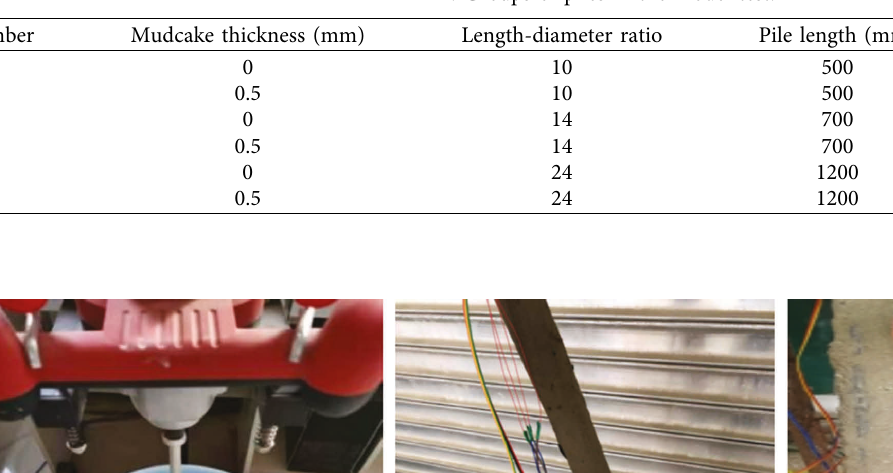
Table 1: Groups of piles in the model